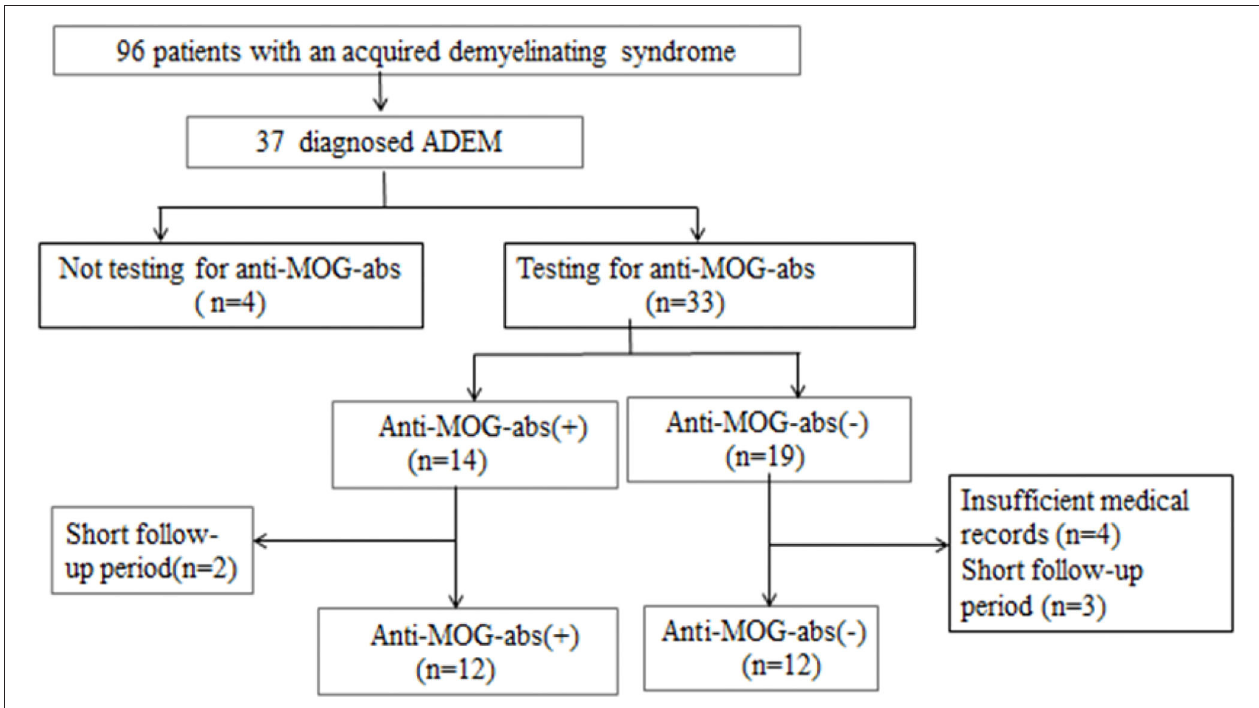
FIGURE 1 | Patient inclusion